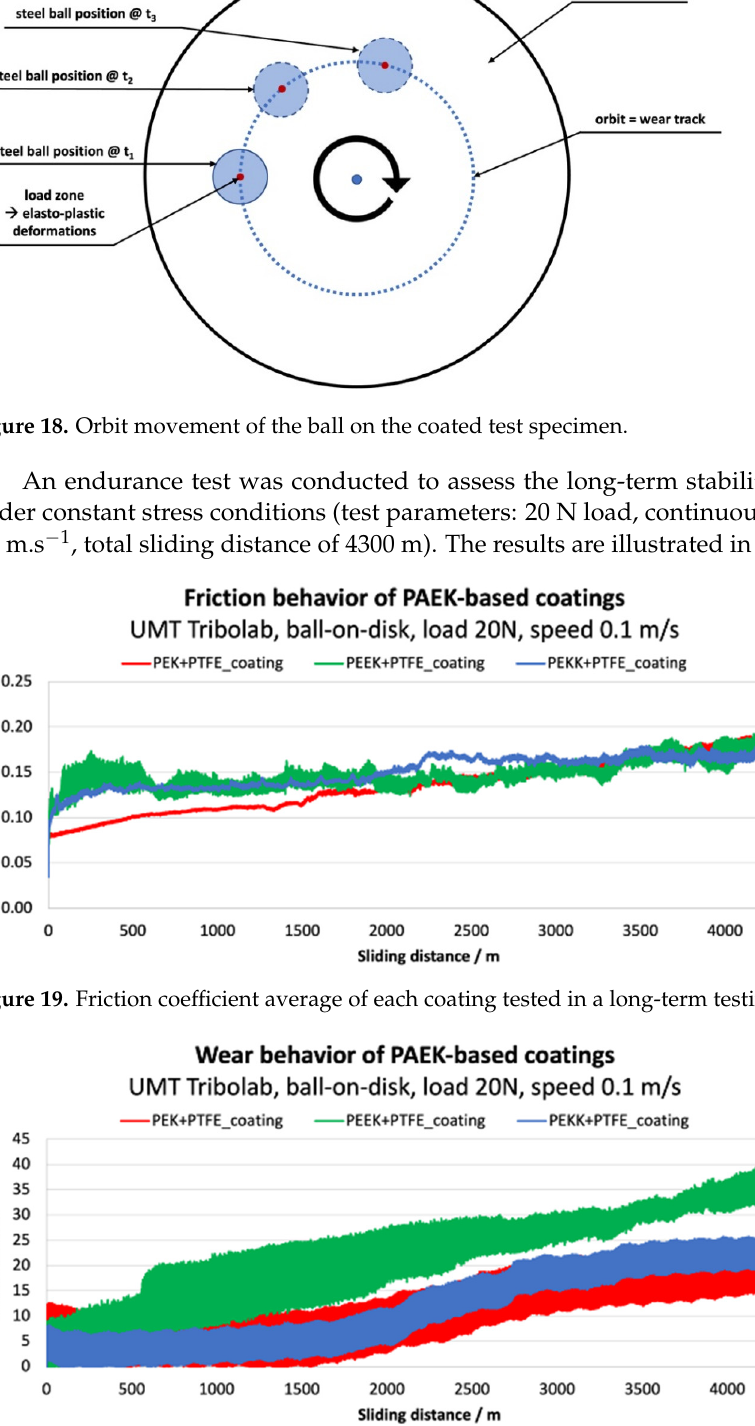
Figure 20. Wear behavior of each coating tested in a long-term testing conditions .